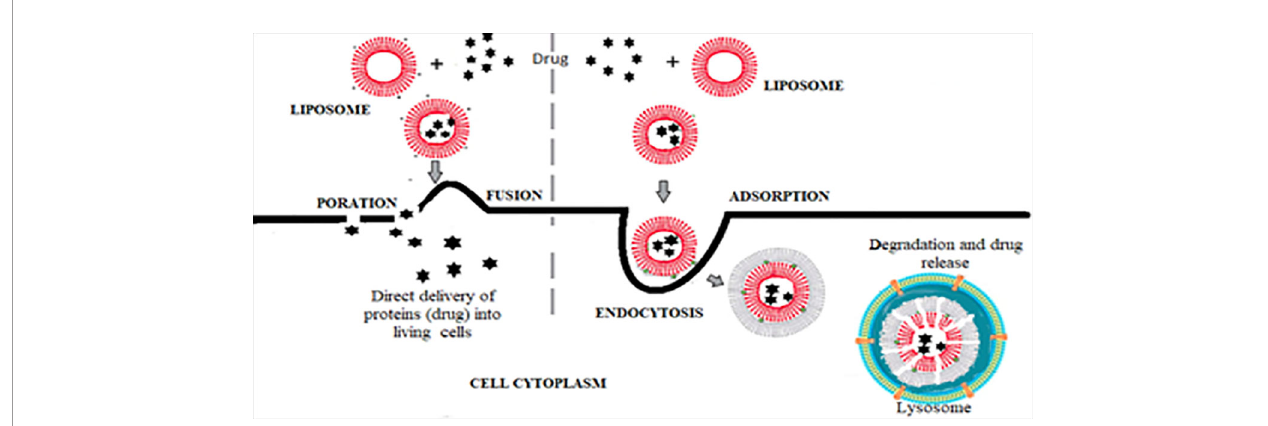
FIGURE 3 | Steps of drug delivery by liposomes either by fusogenic liposome or by endosomal